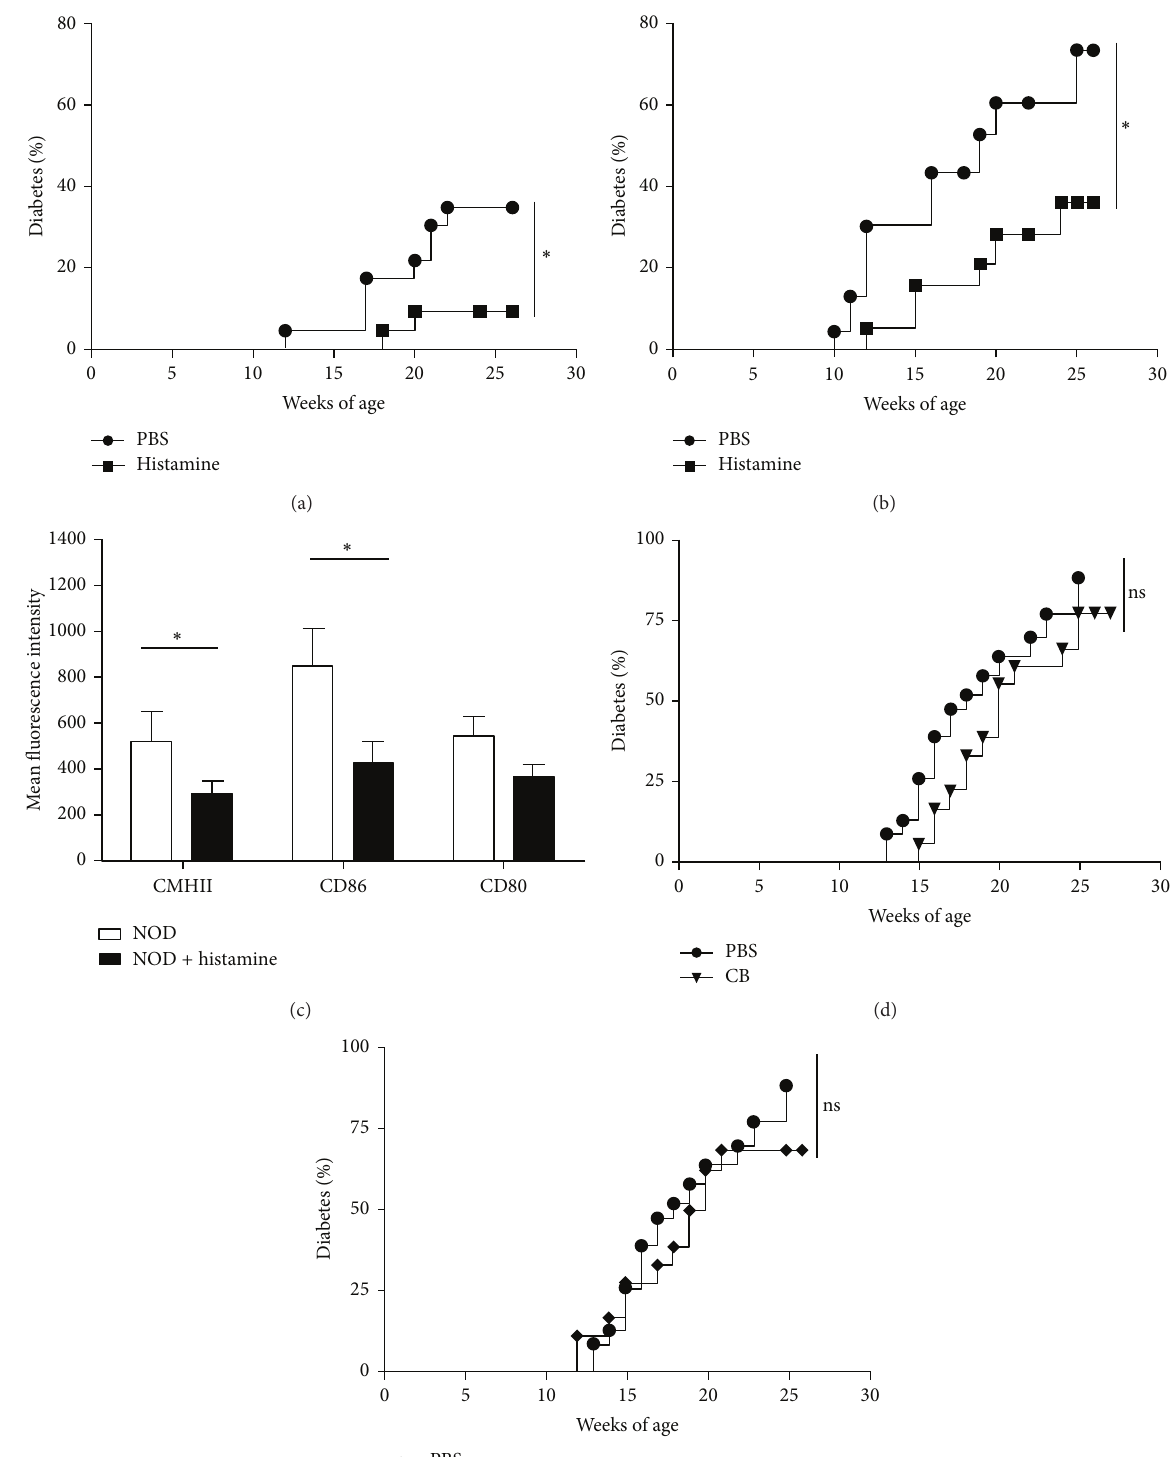
Figure 3: Effects of histamine, CB, and 4-MH on diabetes onset in NOD mice. (a) Effects of histamine deficiency in HDC −/− mice on diabetes onsetversusWTcontrols.DiabetespreventioninNODHDC −/− micetreatedwithhistamine(4mg/kg,i.p.injection,onceaweekfor10weeks) ( ∗ 𝑃 < 0.05 ; 𝑛 = 18 , each group). Mice were measured as diabetic when glycemia > 2.5 g/L. (b) Similar experiment performed with NOD HDC +/+ mice ( ∗ 𝑃 < 0.05 ; 𝑛 = 18 , each group). (c) Mean fluorescnce intensity of MHCII, CD80, and CD86 molecules on mPDCA1 + CD11c low pDCs ( ∗ 𝑃 < 0.05 ; mean ± s.d., 𝑛 = 5 per group). Effects of CB (d) and 4-MH (e) on diabetes onset in WT mice ( 𝑛 = 18 , each